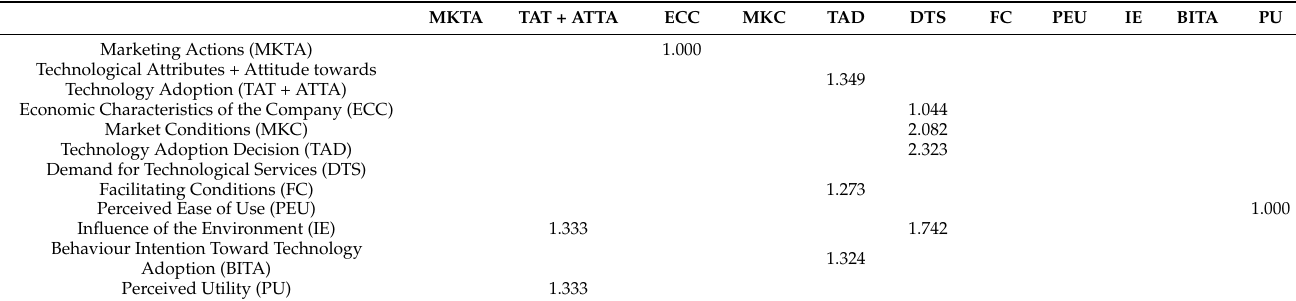
Table 8. Collinearity assessment: VIF values in the structural model.